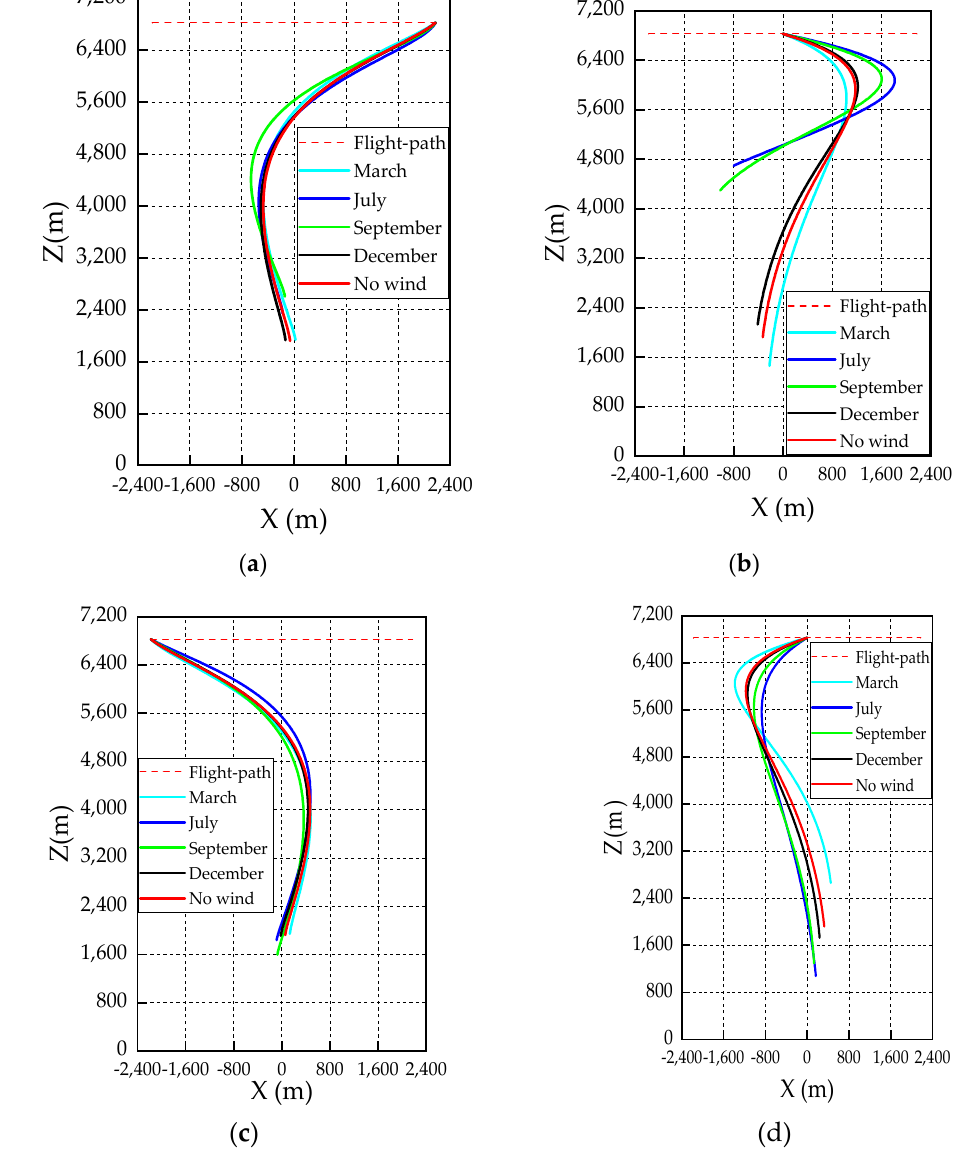
Figure 22. Side view of towline spatial configuration with different phase of the flight: ( a ) phase = 0°; ( b ) phase = − 90°; ( c ) phase = − 180°; ( d ) phase = − 270°.